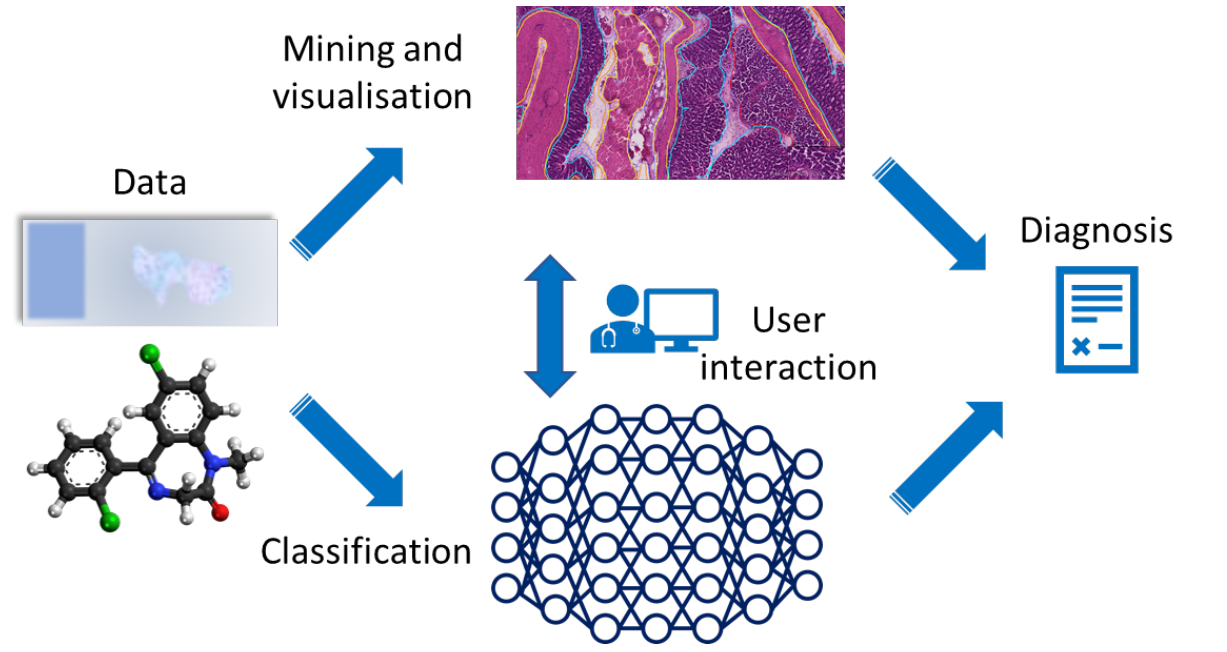
Figure 2. Example of how software for visualisation and data mining can improve the information obtained in a digital pathology workflow.